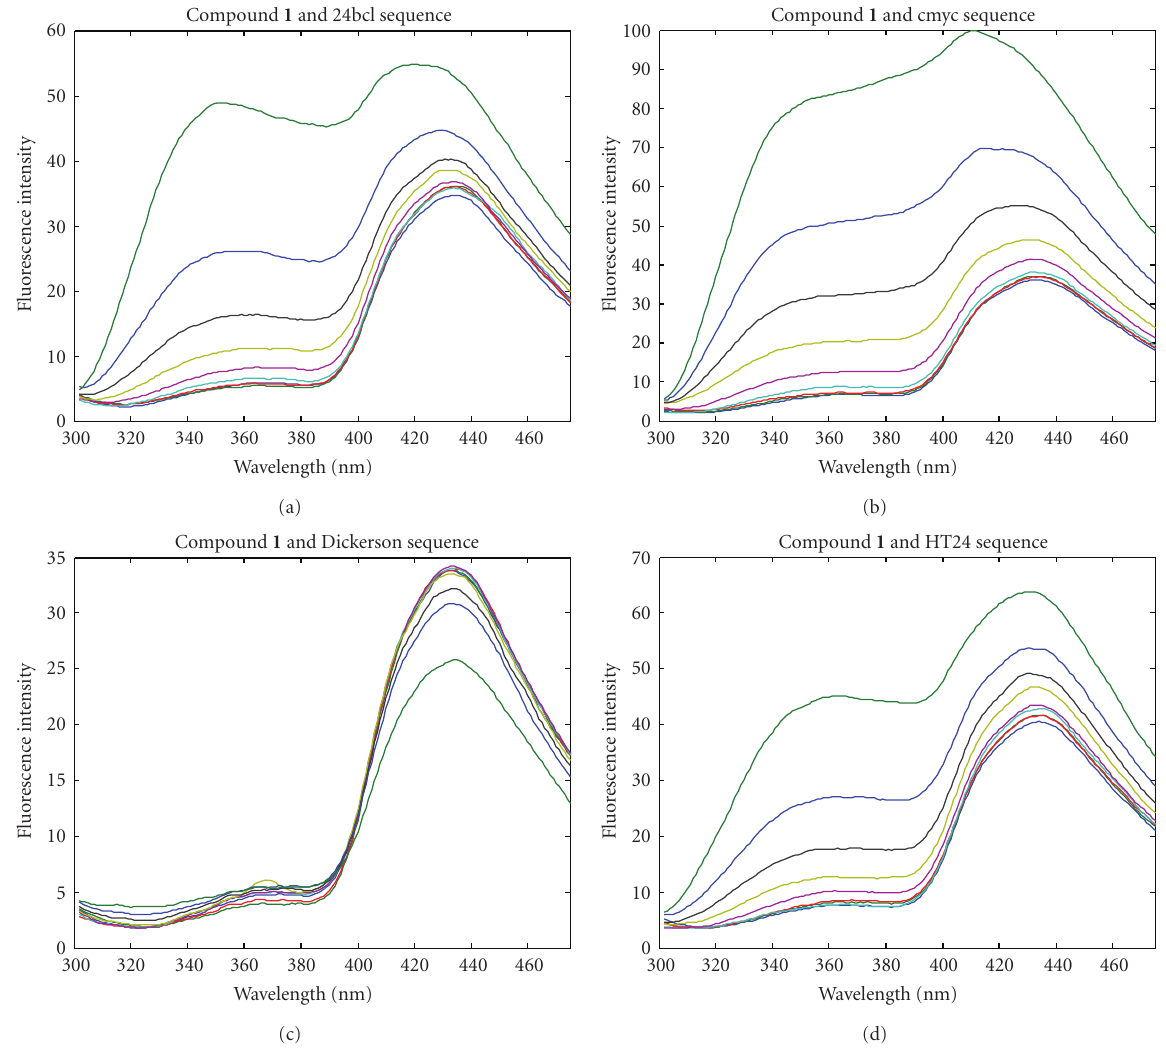
Figure 4: Fluorescence titration spectra. Fluorescence spectra of a 0.2 μ M solution of the acridine derivative after the addition of increasing amounts of oligonucleotide (from 0 to 10 μ M) in potassium phosphate bu ff er. Excitation wavelength is